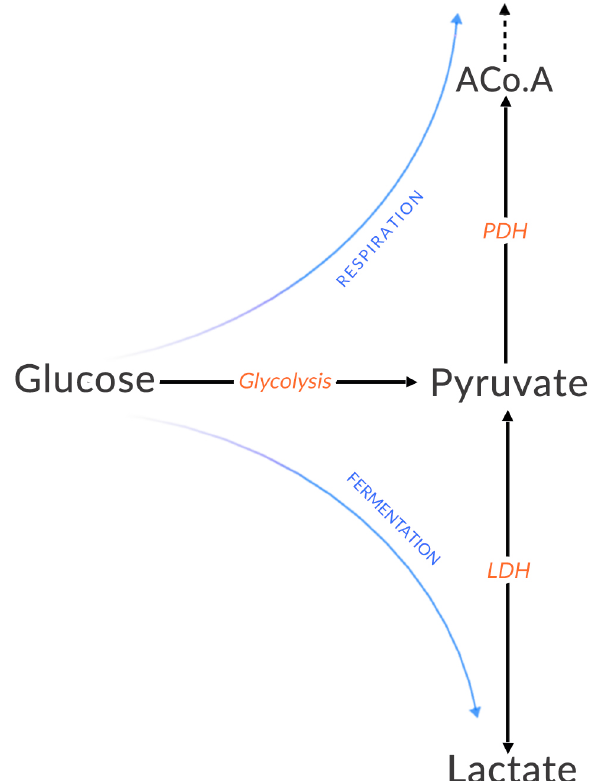
Figure 1. Respiration and fermentation—two processes that begin with glucose and determine the fate of pyruvate. Glycolysis is a sequence of ten reactions that transforms glucose into pyruvate. Conversely, when pyruvate is decarboxylated to acetyl-CoA (Figure 1) by the pyruvate dehydrogenase (PDH) complex and enters the mitochondria, this is called aerobic metabolism . In the mitochondria, it intervenes in the Krebs cycle, generates a molecule of GTP (ener- getically equivalent to a molecule of ATP) and generates NADH and FADH2. These are then used in oxidation-reduction reactions within the respiratory chain located in the inner mitochondrial membrane. The redox couples NAD+/NADH and FAD/FADH2 release energy which makes it possible to pump protons and create an electrochemical gradient within the inter-membrane space of the mitochondria. This energy potential accumulates until it provides sufficient energy for ATP synthase to transform ADP into ATP. This